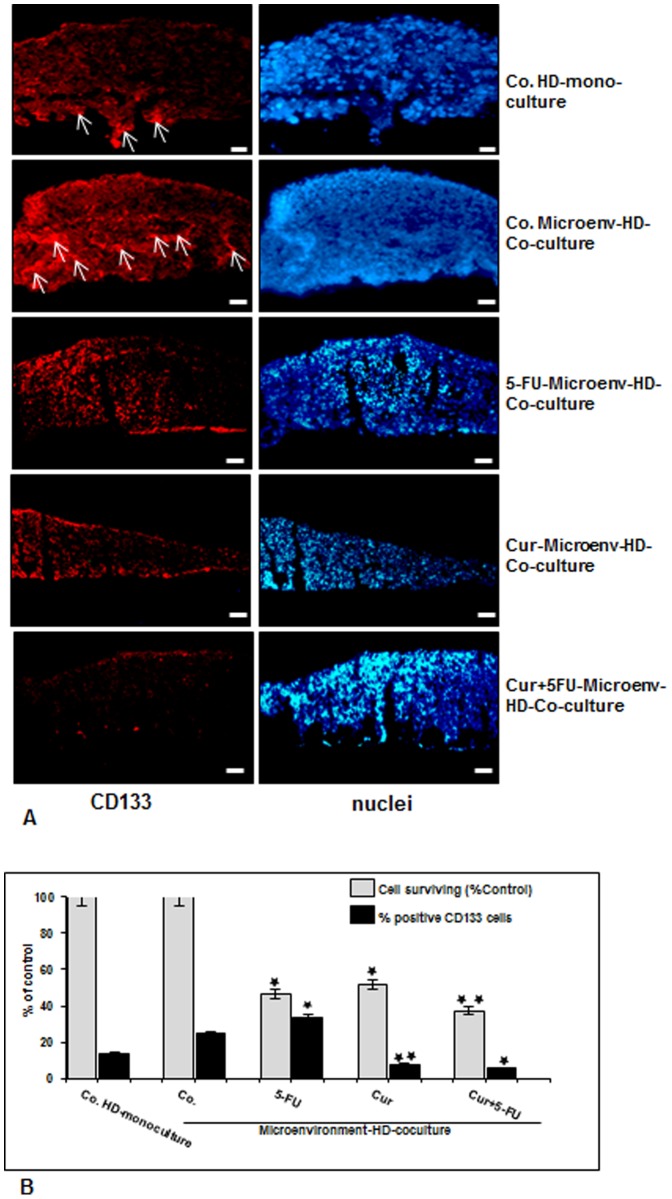
Targeting human colon cancer stem cells (CD133 positive cells) with curcumin and/or 5-FU in high density tumor microenvironment co-culture.A: High density mono-cultures of HCT116 cells were left untreated (A,Co.HD-mono-culture), high density tumor microenvironment co-culture of HCT116/MRC-5 cells were either left untreated (A,Co.Microenv-HD-Co-culture), or treated with 5-FU (5µM) (A, 5-FU-Microenv-HD-Co-culture), curcumin (5µM) (A, Cur-Microenv-HD-Co-culture) or pre-treated with curcumin (5µM) for 4 h, and then exposed to 5-FU (0.1µM) (A, Cur+5FU-Microenv-HD-Co-culture) for 10 days. Immunolabeling was performed with primary antibodies for colon CSC marker (CD133) followed by incubation with rhodamine-coupled secondary antibodies and counterstaining with DAPI to visualize cell nuclei. Images shown are representative of three different experiments. Magnification 400×. bar 30 nm. B: To quantify the amount of CD133-positive cells in high density cultures described above, 100 cells from 15 microscopic fields were counted. The examination was performed in triplicate, and the results are provided as the mean values with S.D. from three independent experiments. Values were compared with the control and statistically significant values with p<0.05 were designated by an asterisk (*) and p<0.01 were designated by an asterisk (**).